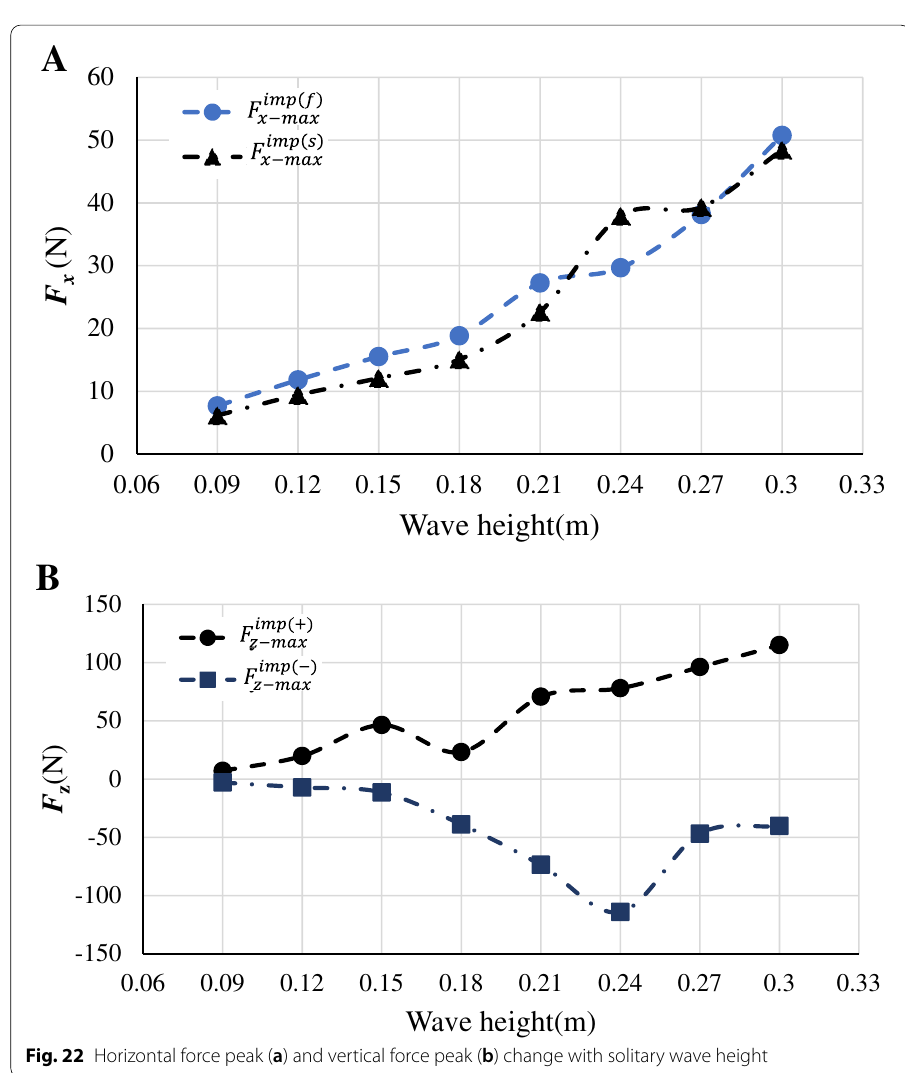
Fig. 22 Horizontal force peak ( a ) and vertical force peak ( b ) change with solitary wave height